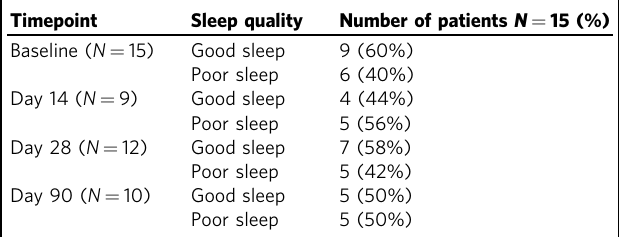
Table 3 Patient sleep quality